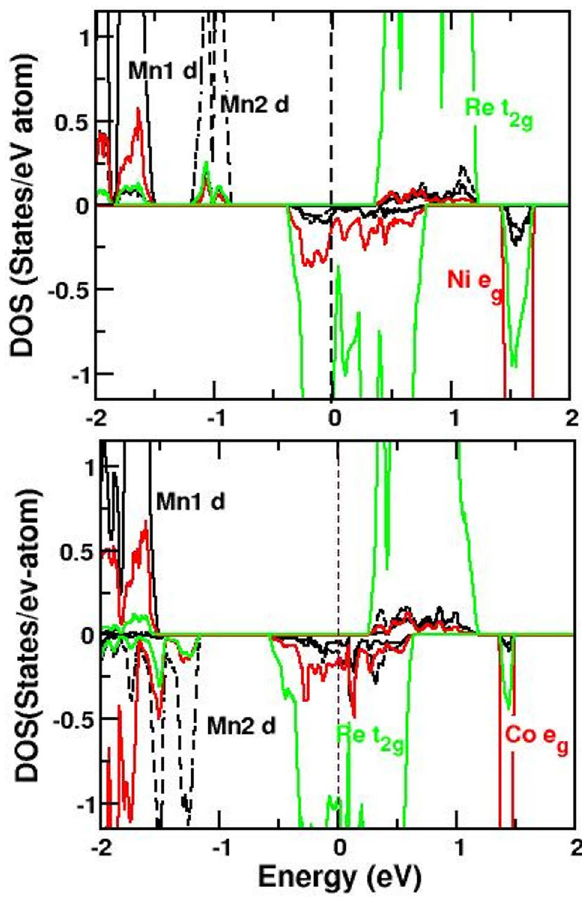
Figure 2. The GGA + U density of states of CMNRO (top) and CMCRO (bottom) projected to Mn1 d (black, solid), Mn2 d (black, dashed), Ni e g / Co d (red, solid) and Re t 2 g (green, solid) states. The zero of the energy is fixed at the Fermi